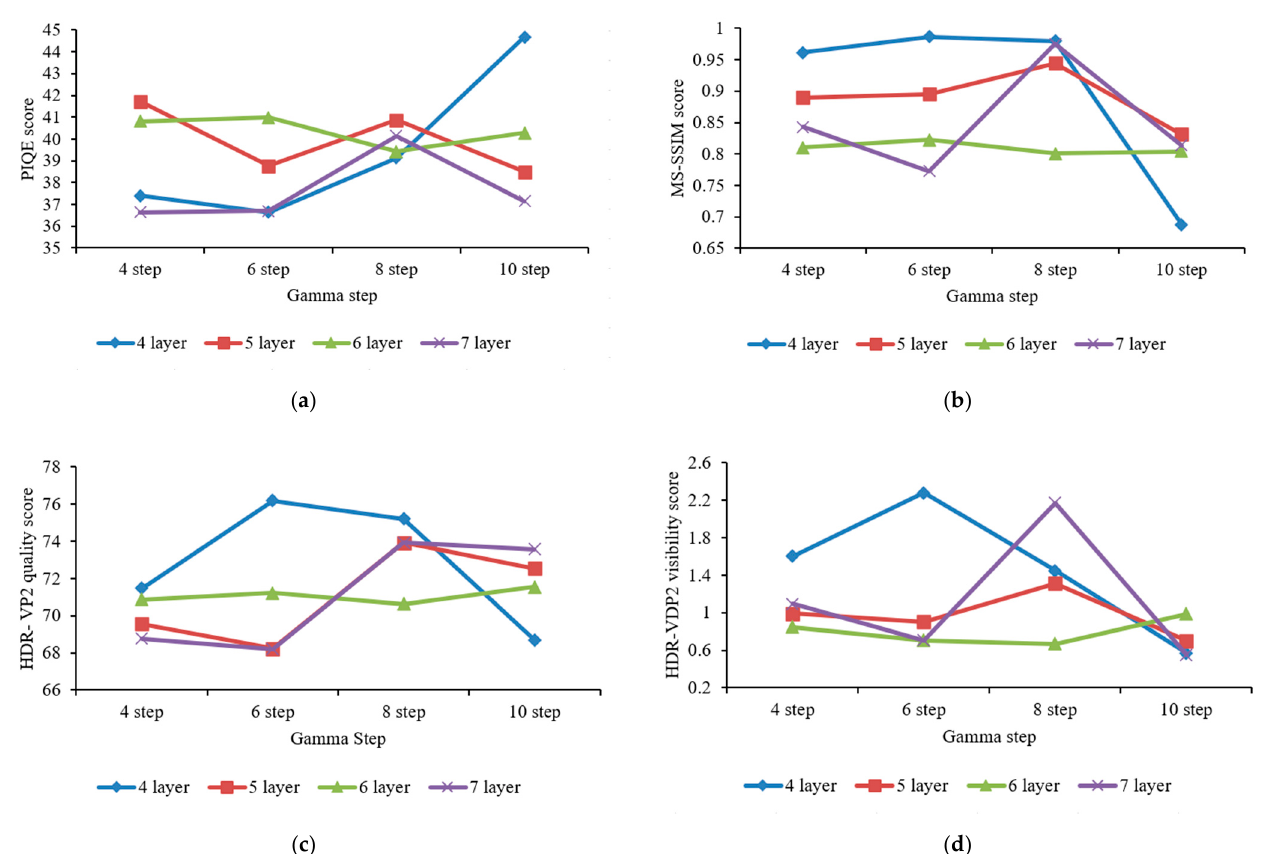
Figure 21. Metric scores for parameter optimization: ( a ) perception-based image quality evaluator, ( b ) multiscale structural similarity, ( c ) HDR-VDP2 quality, and ( d ) HDR-VDP2 visibility.